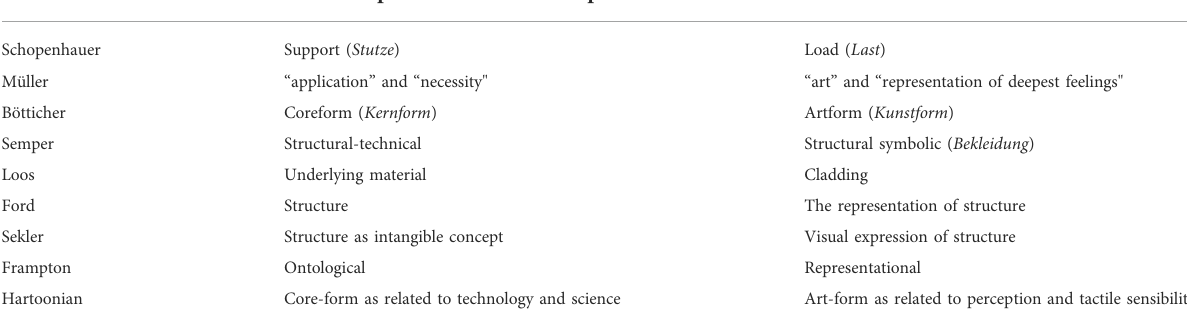
TABLE 1 Dual nature of tectonic relationships and its terminology through time (Reproduced from McCoy,